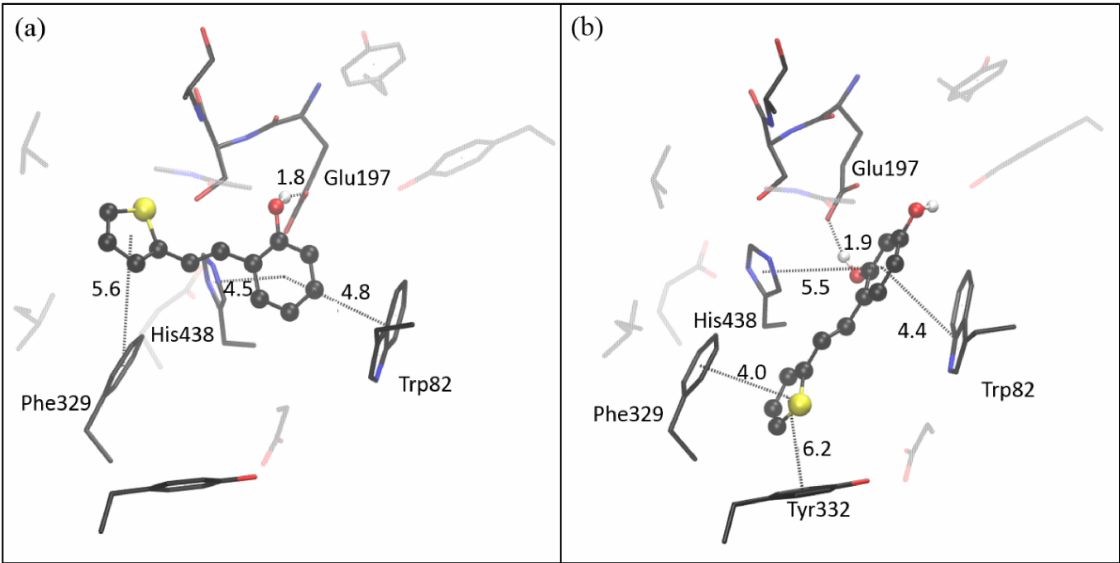
Figure 9. The structure of the active site of BChE docked with II ( a ) and III ( b ). Hydrogens omitted for clarity.